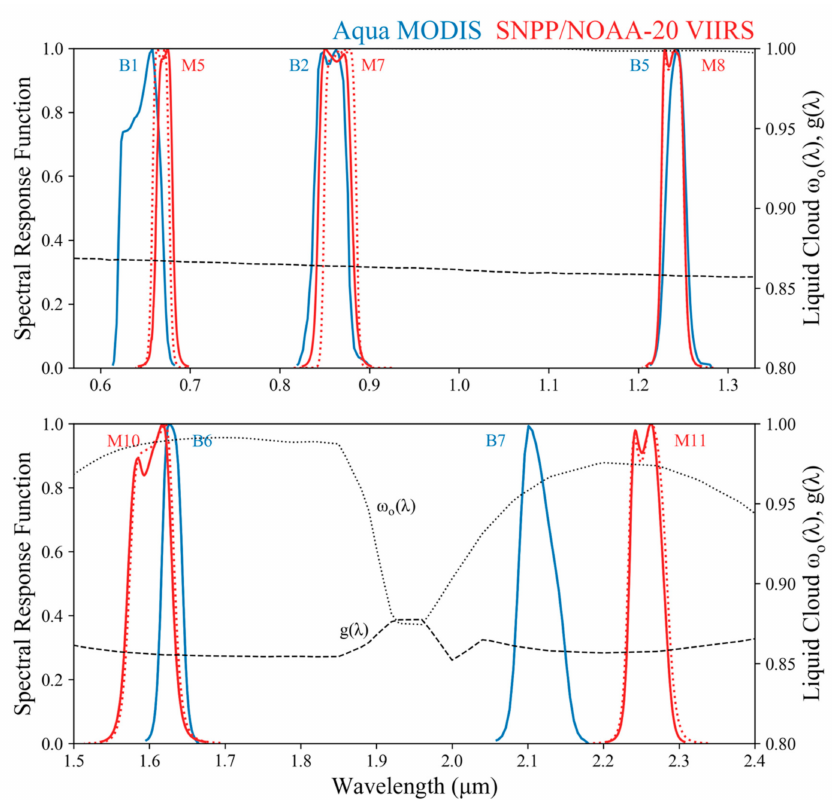
Figure 2. Spectral response functions for the Aqua MODIS (blue lines) and SNPP and NOAA-20 VIIRS (solid and dotted red lines, respectively) channels given in Table 1. The single scattering albedo, ω 0 ( λ ) (dotted black lines), and asymmetry parameter, g( λ ) (dashed black lines), are also shown for a liquid cloud with e ff ective radius 14 µ